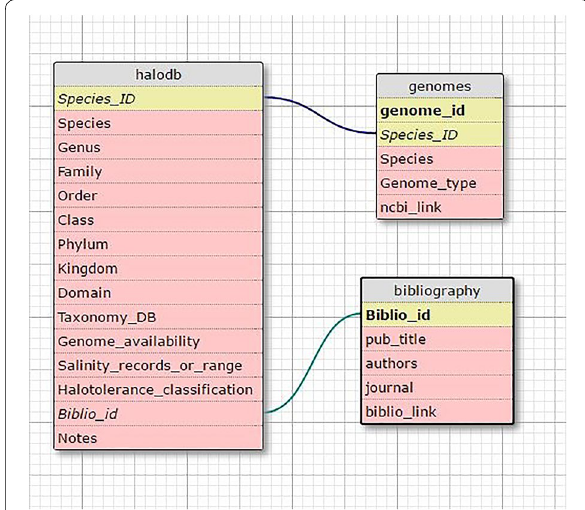
Fig. 1 HaloDom consists of three tables. Foreign key relationships are shown with blue and green lines. Yellow cells are integer numbers while pink cells are varchar, meaning mixed characters and